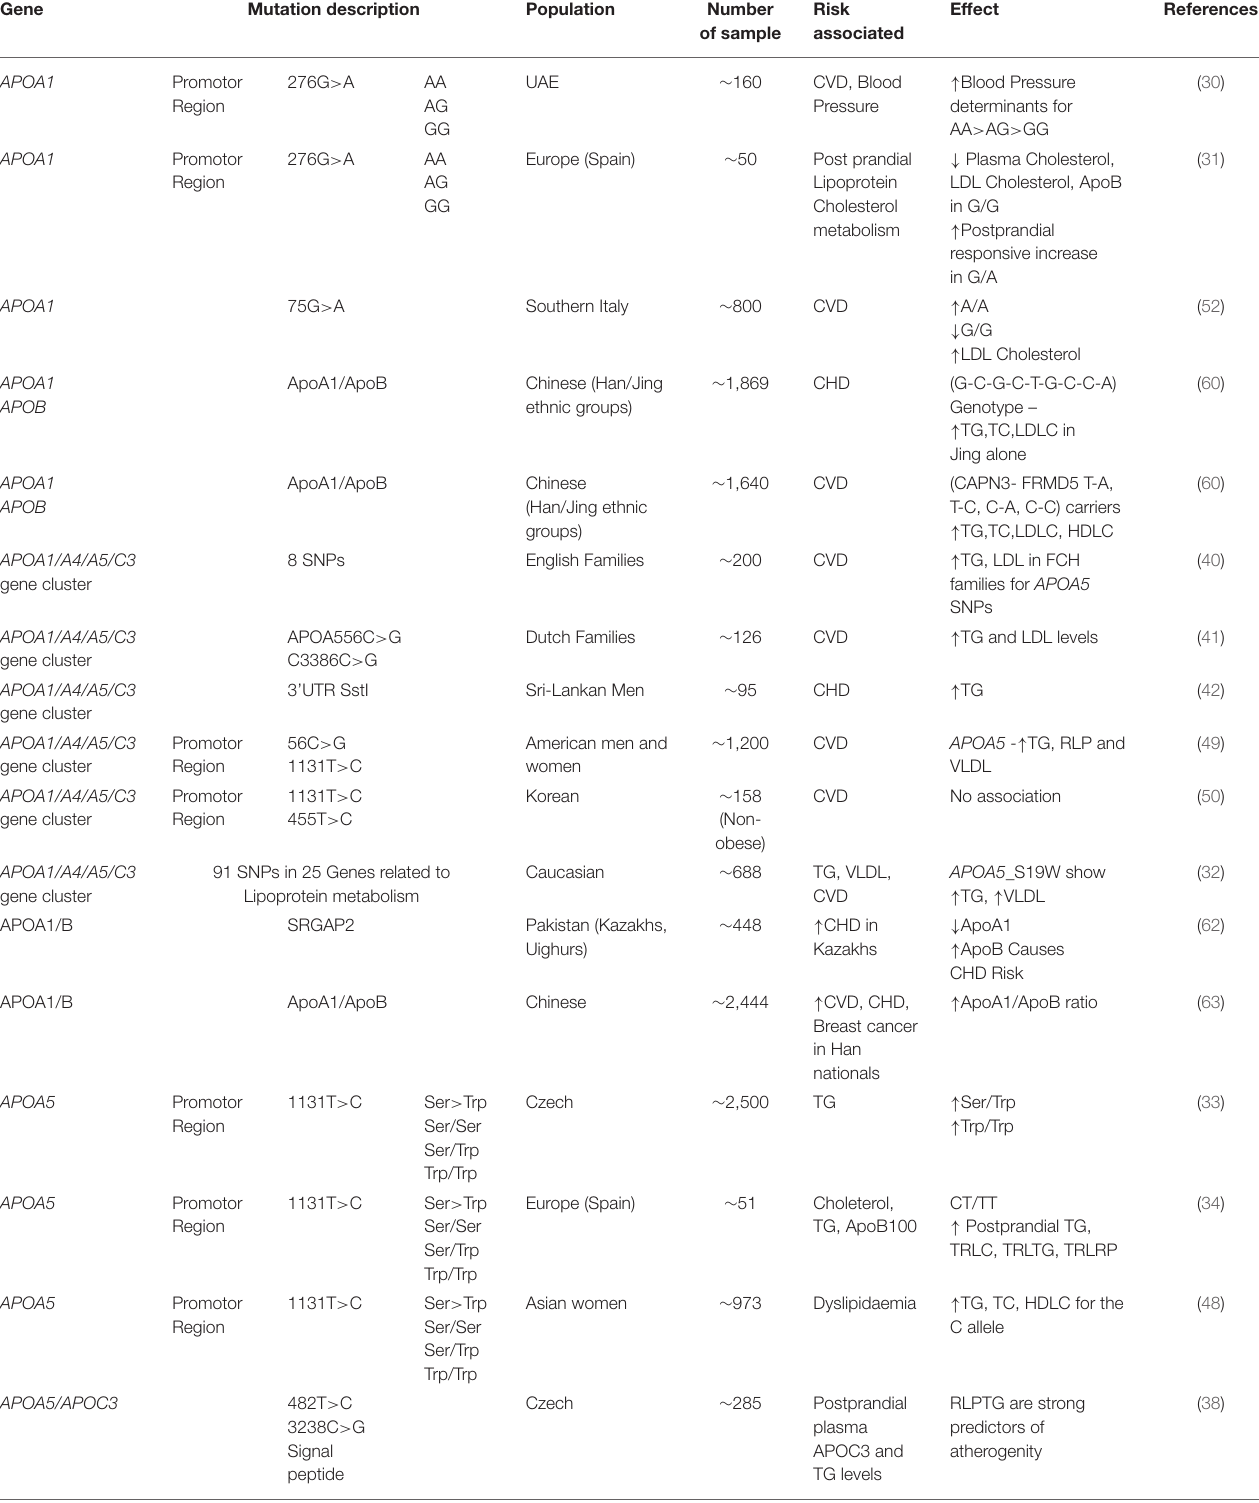
TABLE 3 | List of genetic studies related to the APOA1, APOA5, APOC3, and APOA1/A4/A5/C3 gene cluster, presented with their mutation, population, sample size, and contributing medical risks. Gene Mutation description Population Number